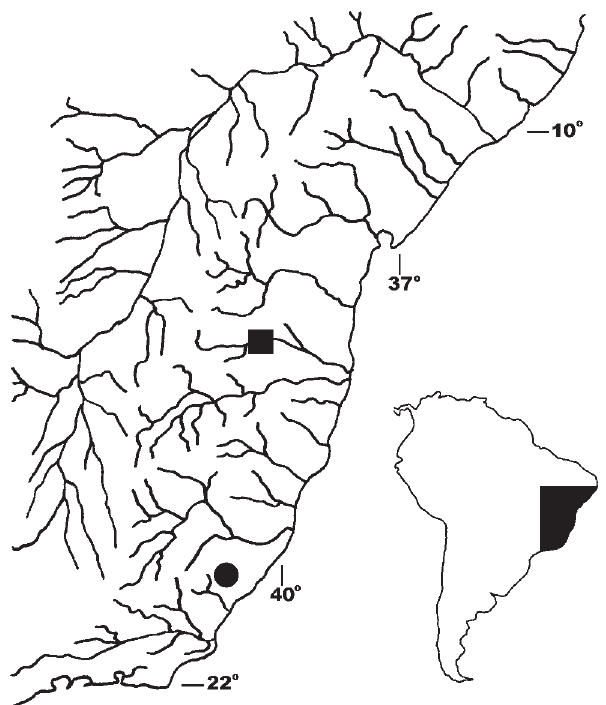
Fig. 1. Coastal drainages of states of Espírito Santo and Ba- hia, eastern Brazil, showing the distribution of Astyanax microschemos (dot) and Astyanax pelecus